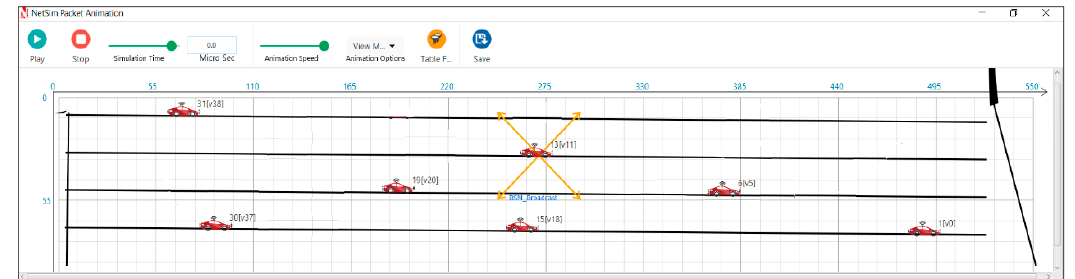
Figure 9. Clustering of vehicles in sparse traffic scenario.